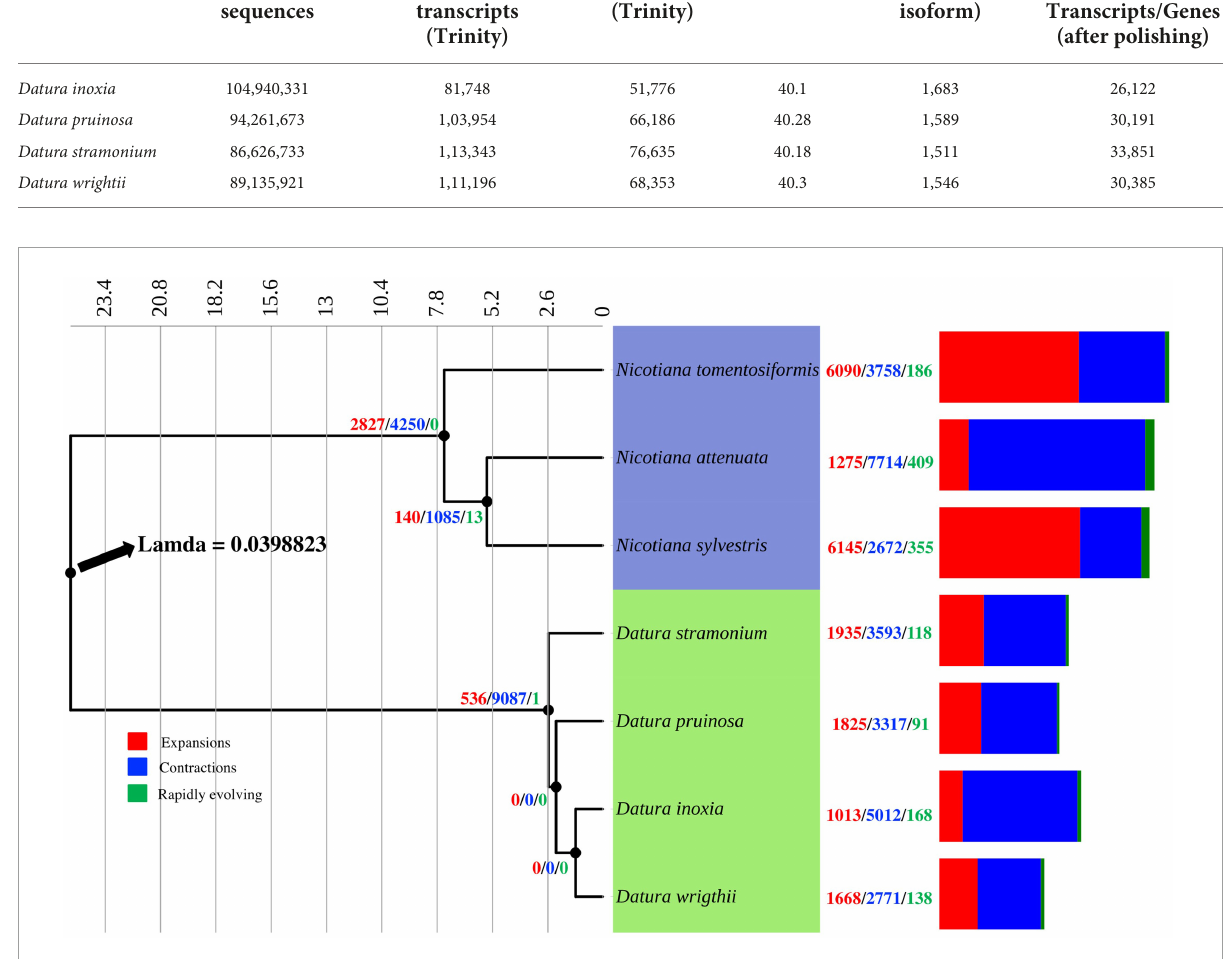
FIGURE1 Phylogenetic time tree constructed from concatenated alignment of 3,219 orthogroups consistent entirely of single-copy genes from four Datura species and three Nicotiana species. Nicotiana and Datura species diverged approximately 25 Mya. Expansions (red), contractions (blue) and rapidly evolving gene families (green) are shown at nodes and terminal branches. The rate of gene gain and lost ( λ ) resulted from CAFE analysis was 0.039 for the whole